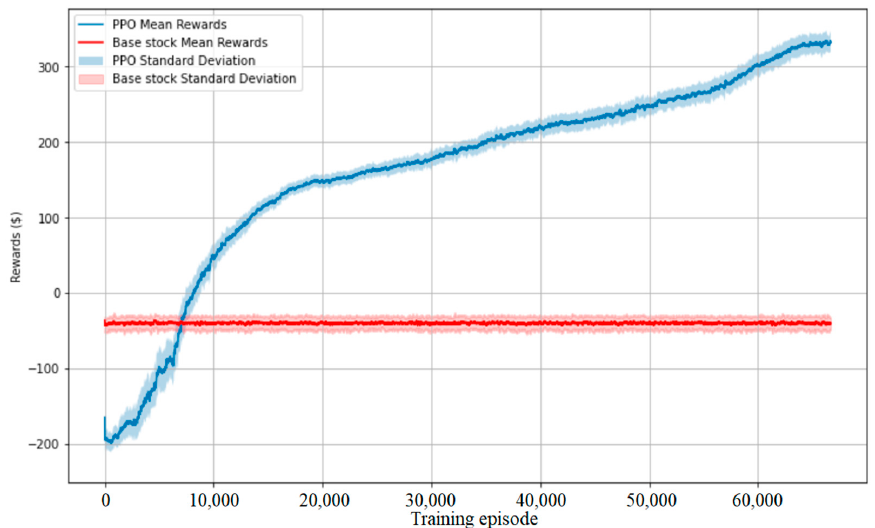
Figure 6. The PPO agent decisively outcompetes the base-stock policy under more challenging environment settings.